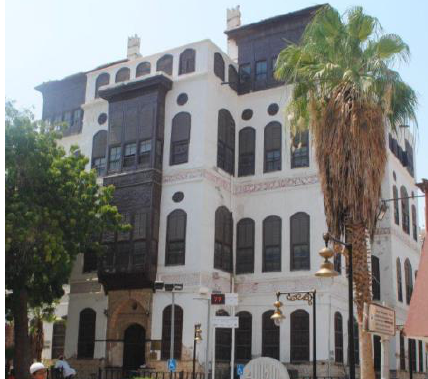
Figure 1: Nasif Historical